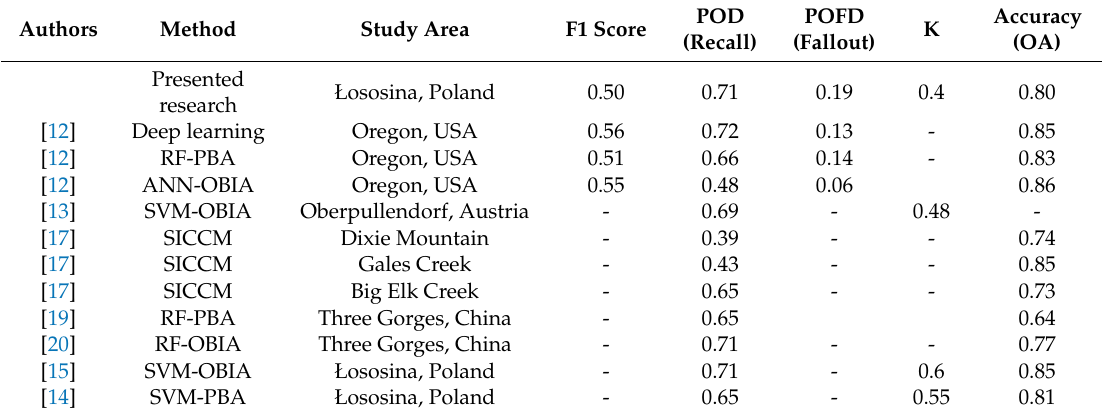
Table 8. Comparison with other works and accuracy assessment